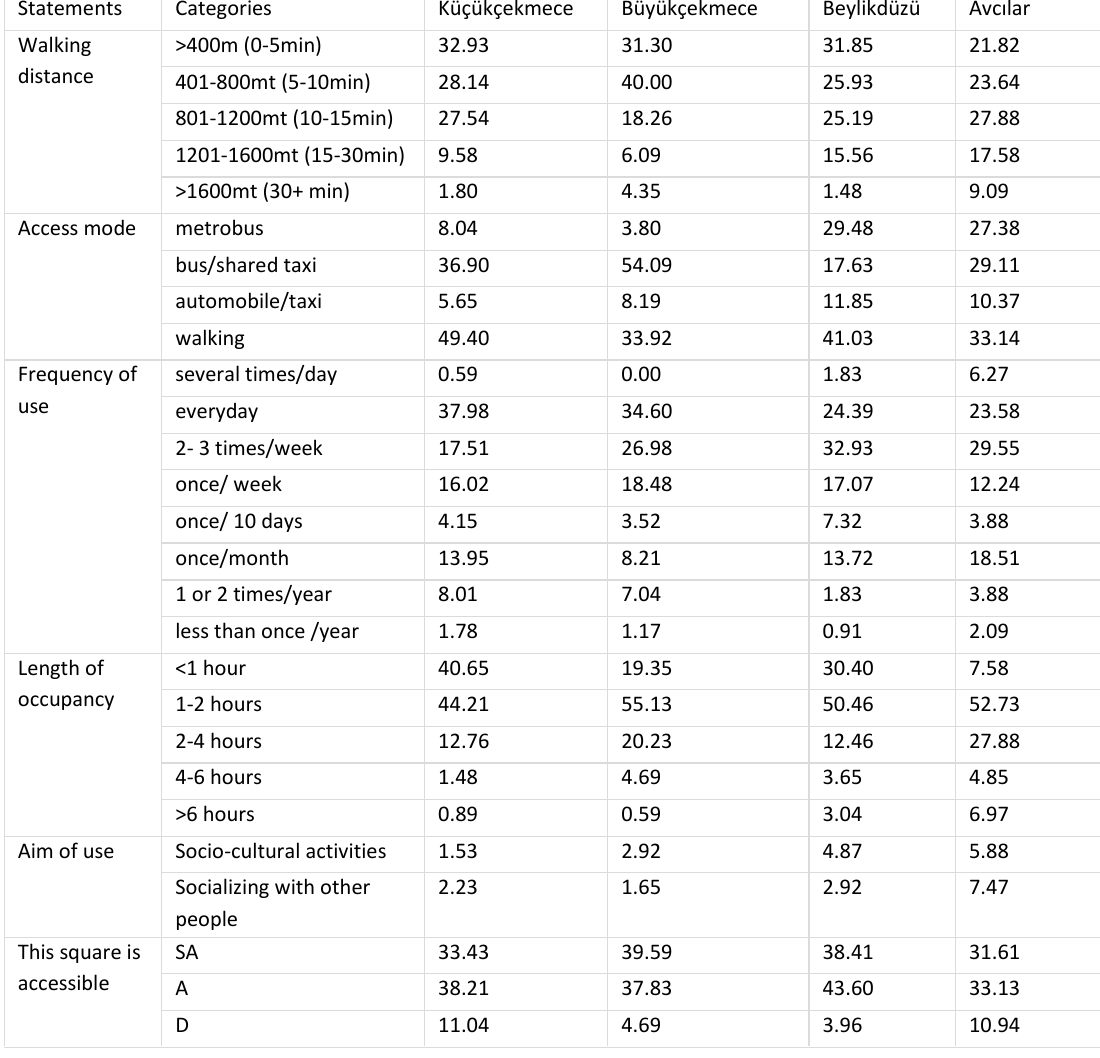
Table 1 Findings indicating percentages obtained from the user questionnaires in each